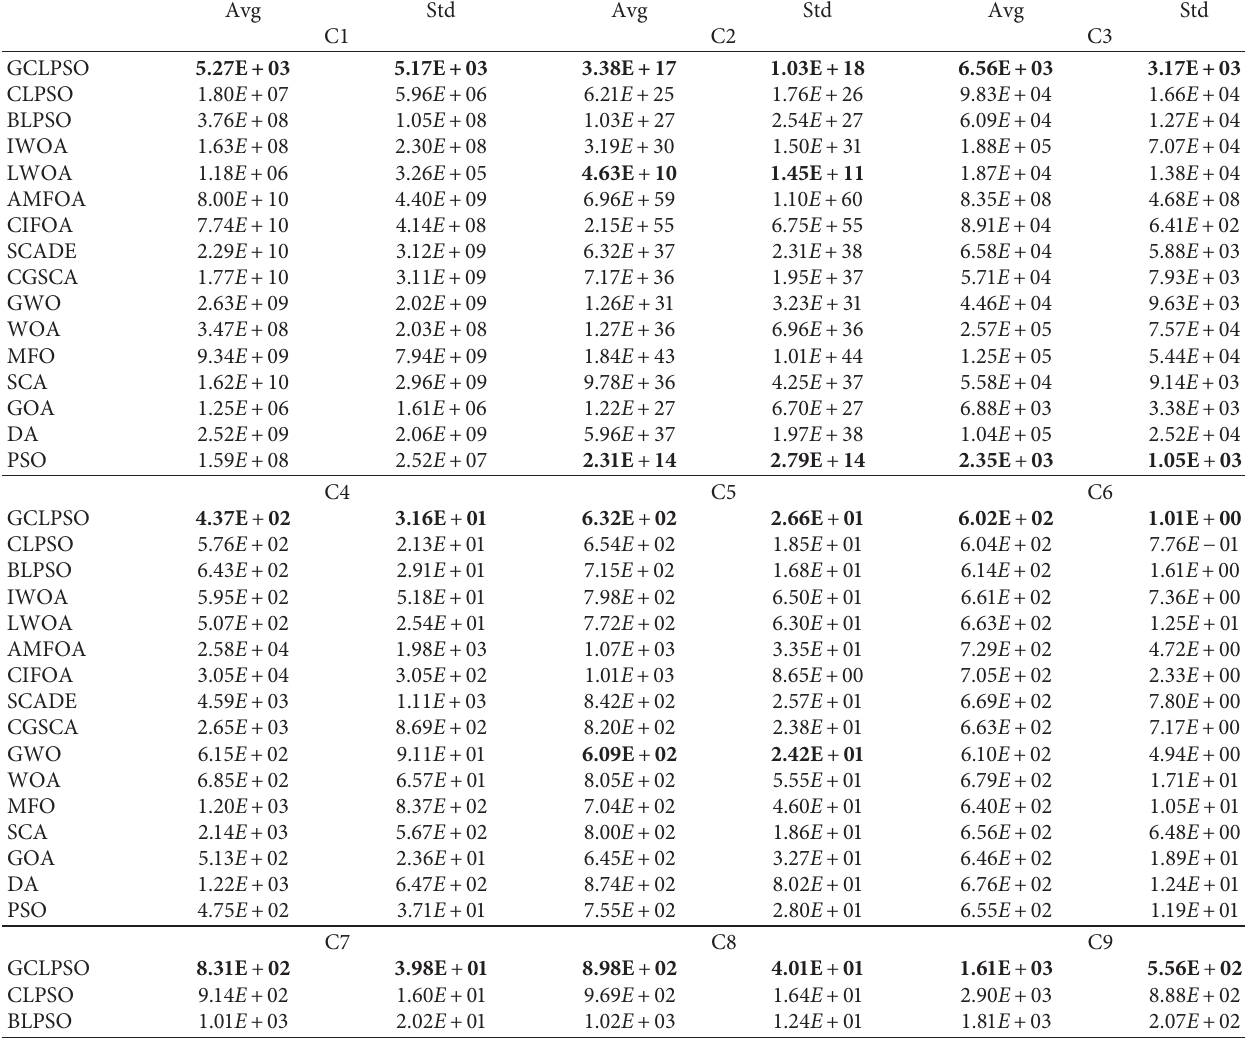
Table 4: Comparison of results of different